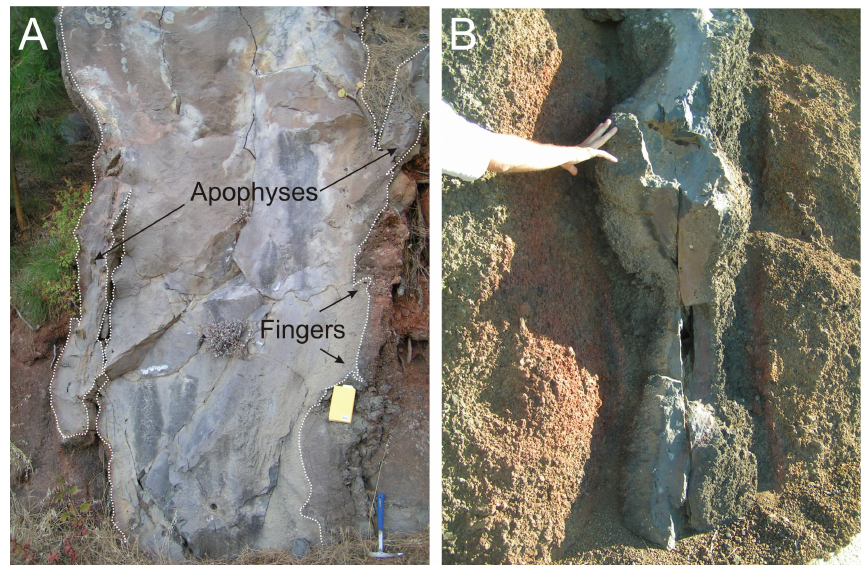
Fig. 6. Feeder dykes showing irregular margins: (A) the Chese feeder dyke (Tenerife) shows several apophyses and fingers. (B) The Negrita feeder dyke (Tenerife) displays a ball-and-chain structure in its more superficial part, when intruding pyroclastic deposits of the cinder cone formed during its